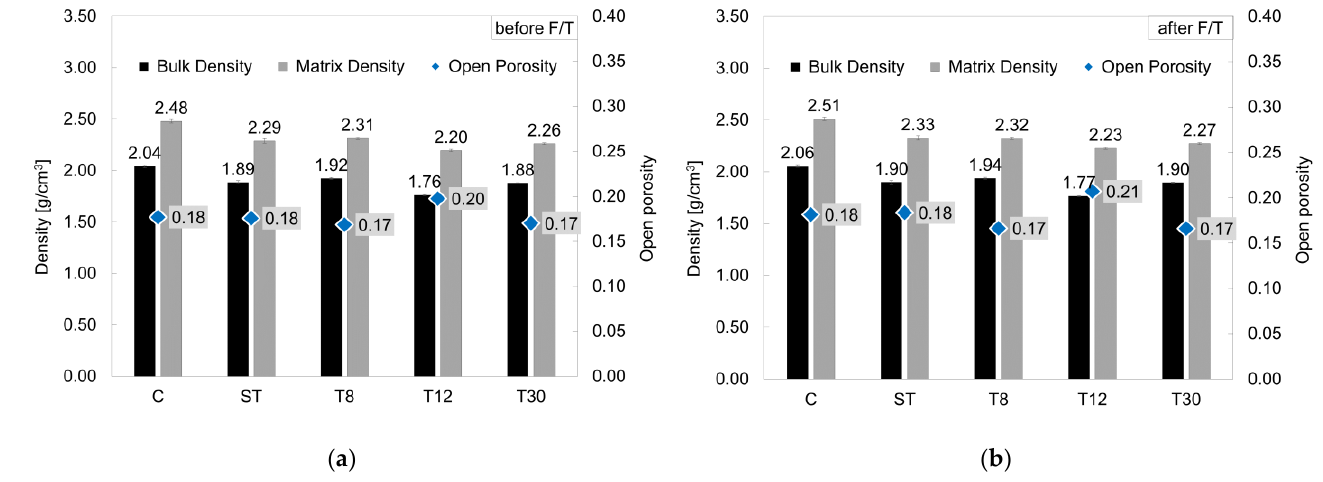
Figure 7. Open porosity, bulk density and matrix density measured ( a ) before and ( b ) after freeze/thaw cycles. The error bars represent the standard deviation.